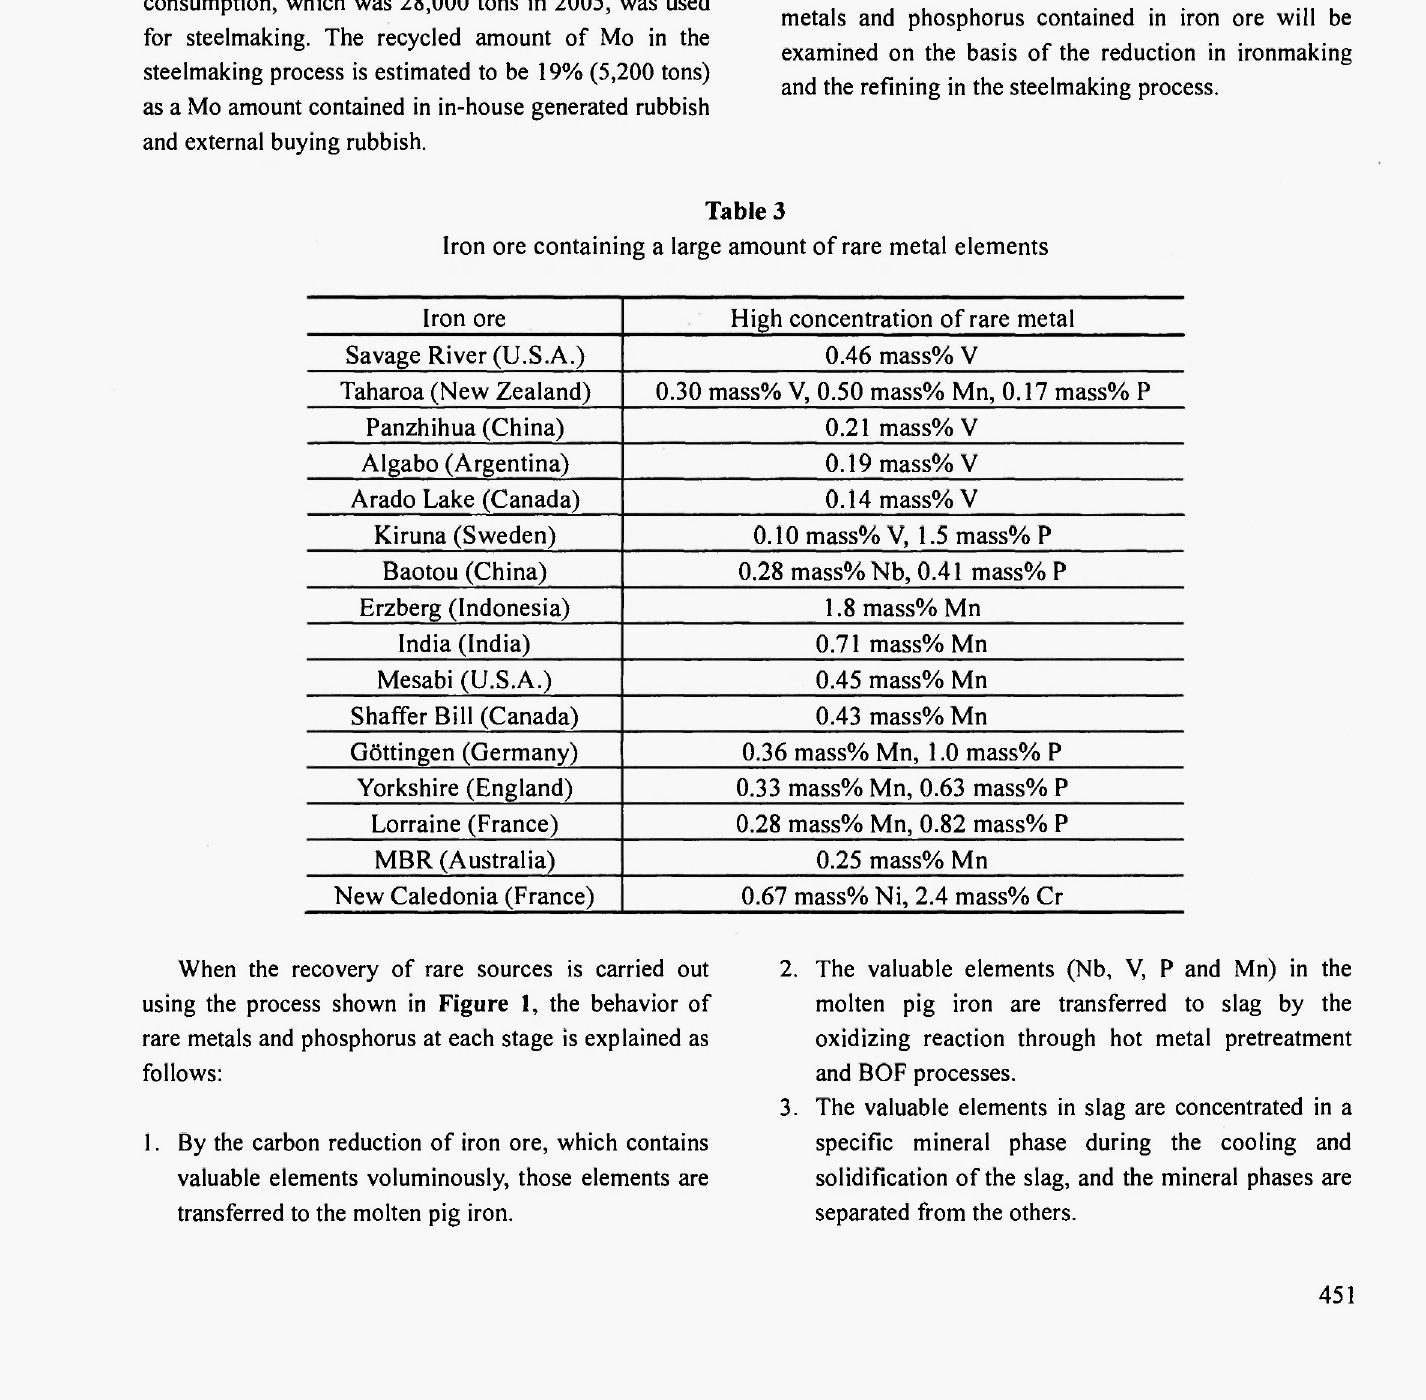
Iron ore containing a large amount of rare metal elements Iron ore High concentration of rare metal Savage River